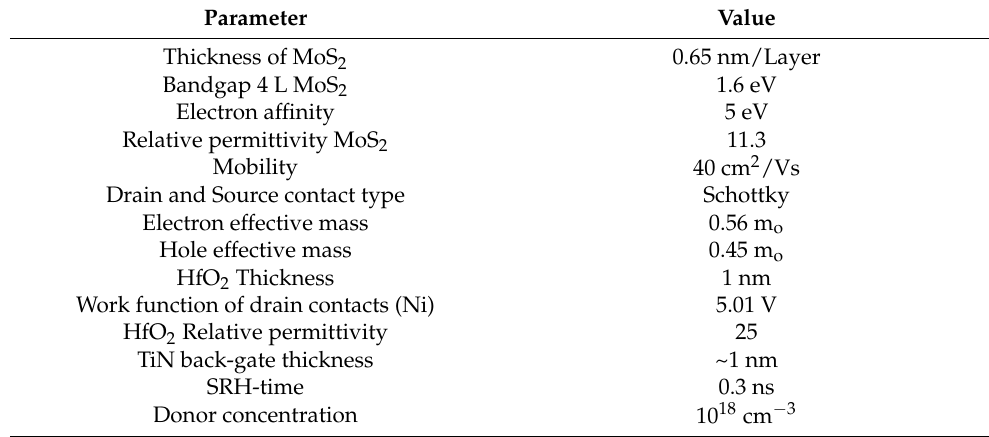
Table 1. Input parameters used in this simulation work. Data from